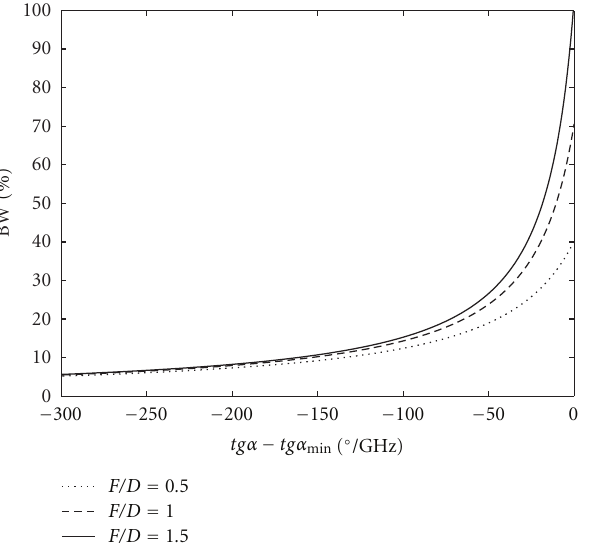
Figure 5: Percent bandwidth versus element phase curve slope for di ff erent F/D ratios ( D = 12 . 4 λ ).